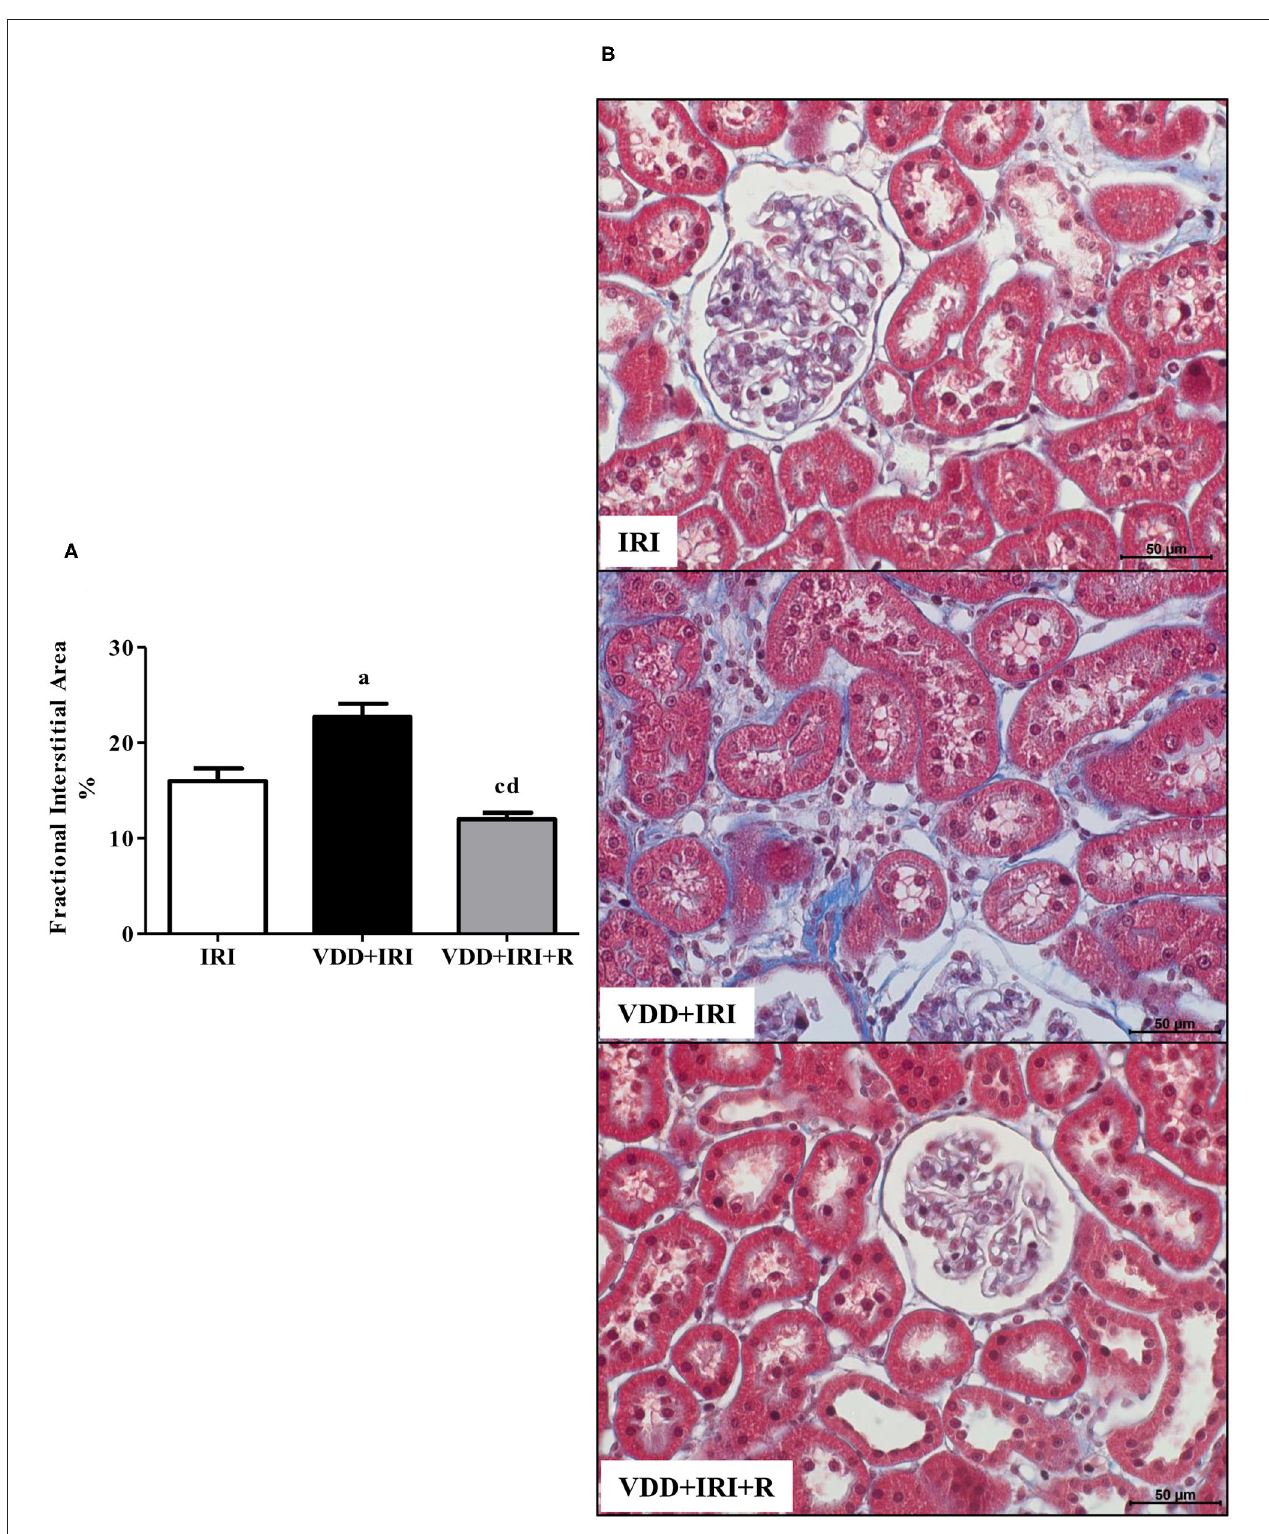
FIGURE 2 | Fractional interstitial area (FIA) in the renal cortex evaluated 90 days after ischemia/reperfusion insult (IRI) on day 30. (A) Bar graph of FIA values. (B) Representative photomicrographs of renal histological changes from a IRI, VDD + IRI and VDD + IRI + R rat ( × 400). Note that FIA is significantly smaller in VDD + IRI + R than in the other groups. Data are mean ± SEM. a p < 0.001, c p < 0.05 vs. IRI; d p < 0.001 vs. VDD + IRI. VDD, vitamin D deficiency; R, vitamin D replacement. Diet protocol: IRI, standard diet for 120 days; VDD + IRI, vitamin D-free diet for 120 days; and VDD + IRI + R, vitamin D-free diet in the first 30 days and standard diet in the last 90